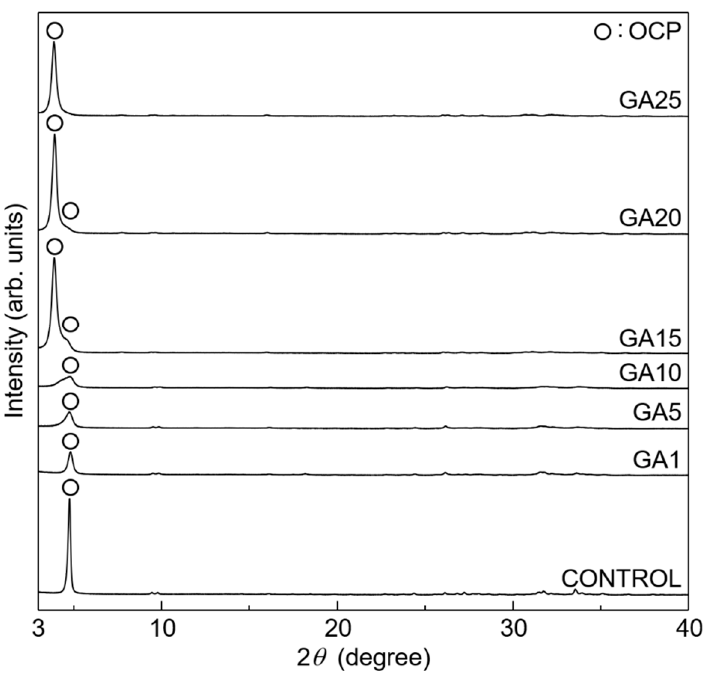
Figure 2. XRD patterns of the OCP samples synthesised using 1–25 mmol of glutaric acid as compared to plain OCP (control).